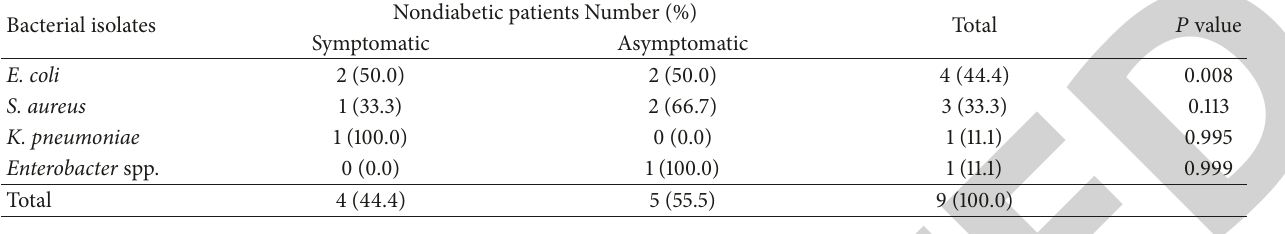
Table 4: Frequency and types of bacterial species isolated from symptomatic and asymptomatic nondiabetic patients urine culture attending Debre Tabor Hospital, Northwest Ethiopia, 2015.